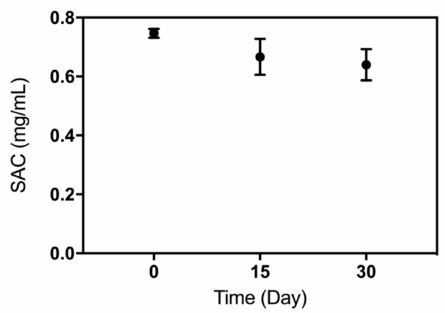
Figure 8. The saturation adsorption capacity (SAC) of the VHH-based immunoadsorbent preserved at 4 ◦ C for one month (each experiment was performed three